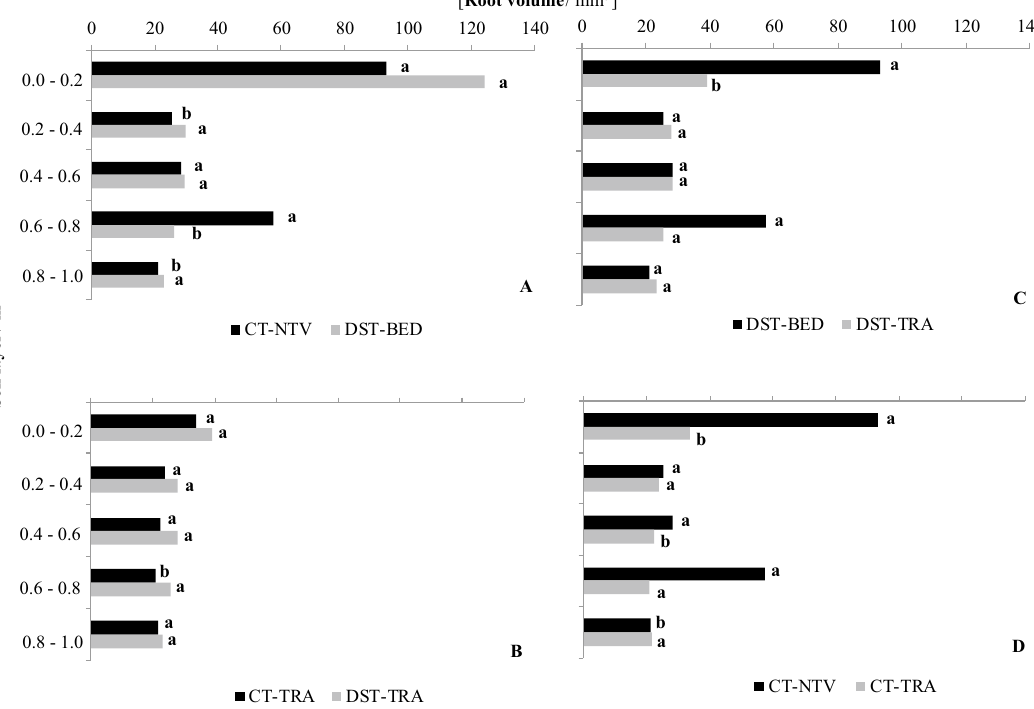
Figure 9. Root volume for: ( A ) conventional tillage no traffic lane (CT-NTV) and deep strip tillage bed with no traffic (DST-BED), ( B ) conventional tillage traffic lane (CT-TRA) and deep strip tillage traffic lane (DST-TRA), ( C ) DST-BED and DTS-TRA, and ( D ) CT-NTV and CT-TRA. Different lower case letters indicate significant differences between treatments with the p ≤ 0.15 confidence intervals of the log-transformed